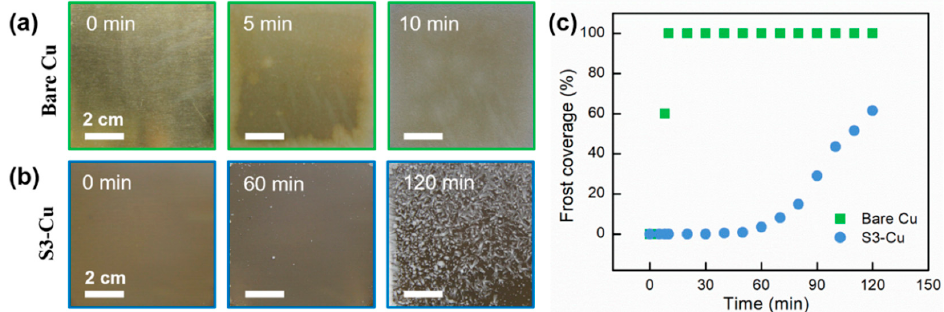
Figure 4. Anti-frosting performance of Cu samples. ( a ) Frost completely covers the entire bare Cu surface after 10 min. ( b ) Frost first appears after 60 min during a frosting test on the optimized S3-Cu sample, and the coverage remains <70% after 120 min under high SSD (2.45). ( c ) Frost coverage comparison between bare Cu and S3-Cu.